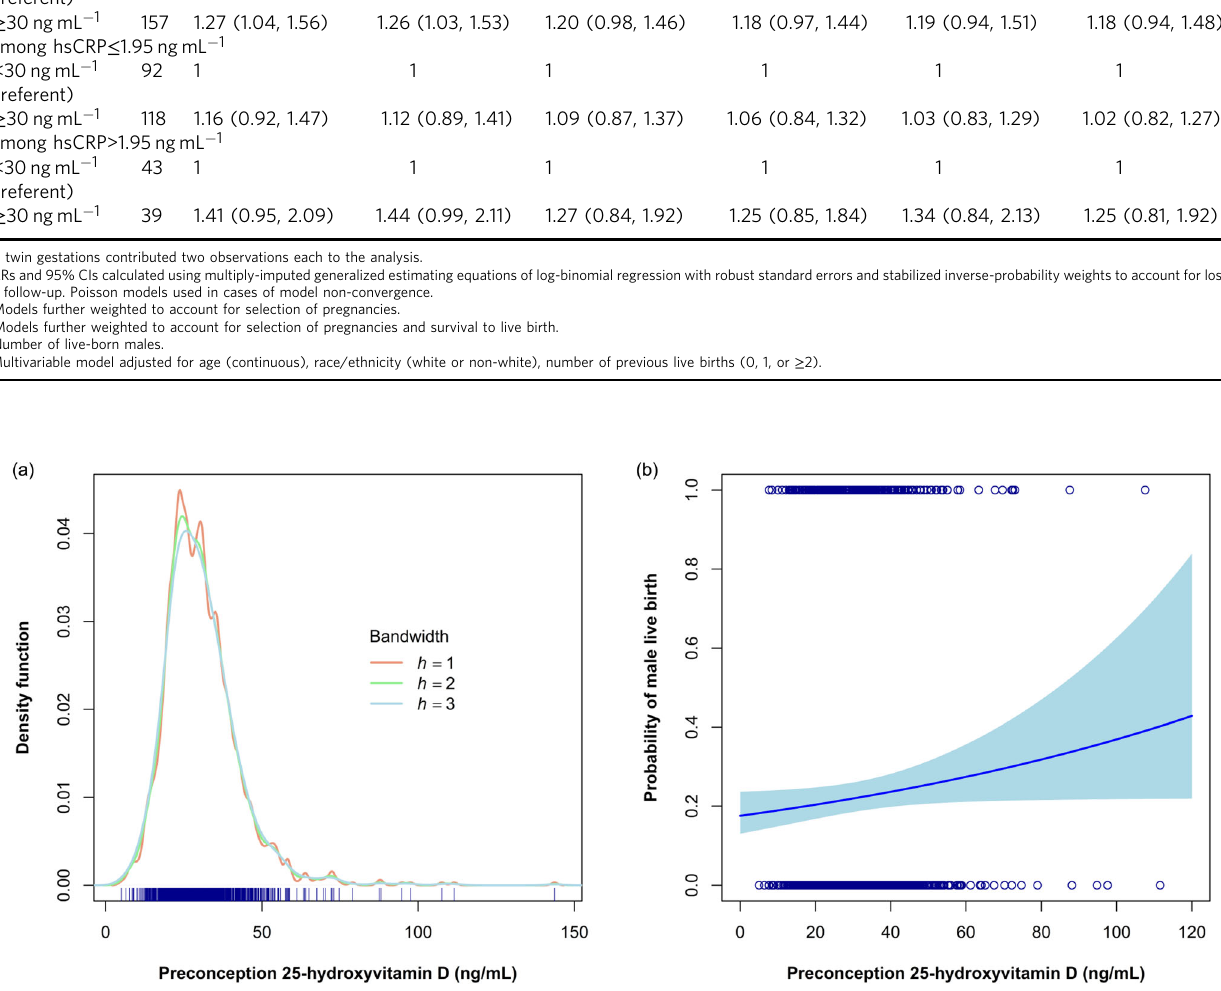
Fig. 1 Distribution of preconception 25-hydroxyvitamin D [25(OH)D] levels and associations with male live birth in the Effects of Aspirin in Gestation and Reproduction (EAGeR) trial. a Rug plot (navy) of preconception 25(OH)D levels with kernel density estimates for multiple bandwidth smoothers ( h = 1, 2, and 3); b Scatterplot of vitamin D levels (navy) and probability of male live birth with regression line (blue) and 95% con fi dence cloud (light blue) in a single imputed dataset ( n = 1228).